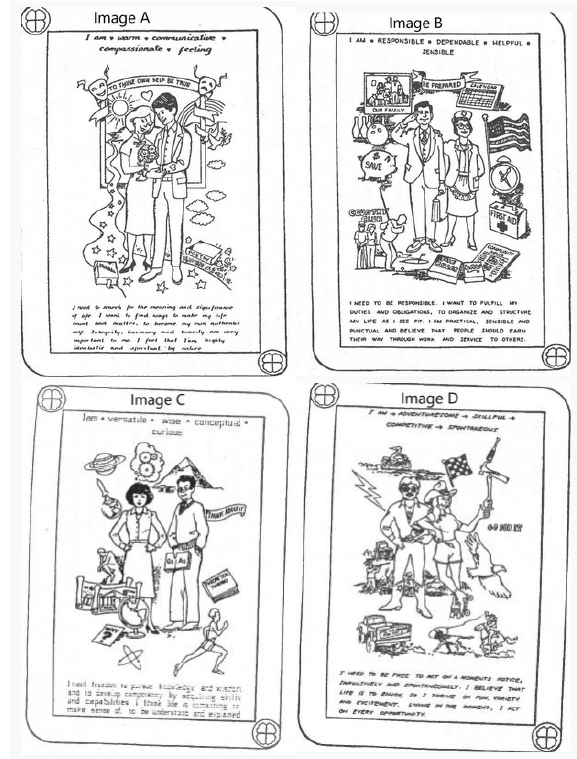
Figure 1. The four images to determine a participant’s True Colors self-schema. Image A says “I am warm, communicative,